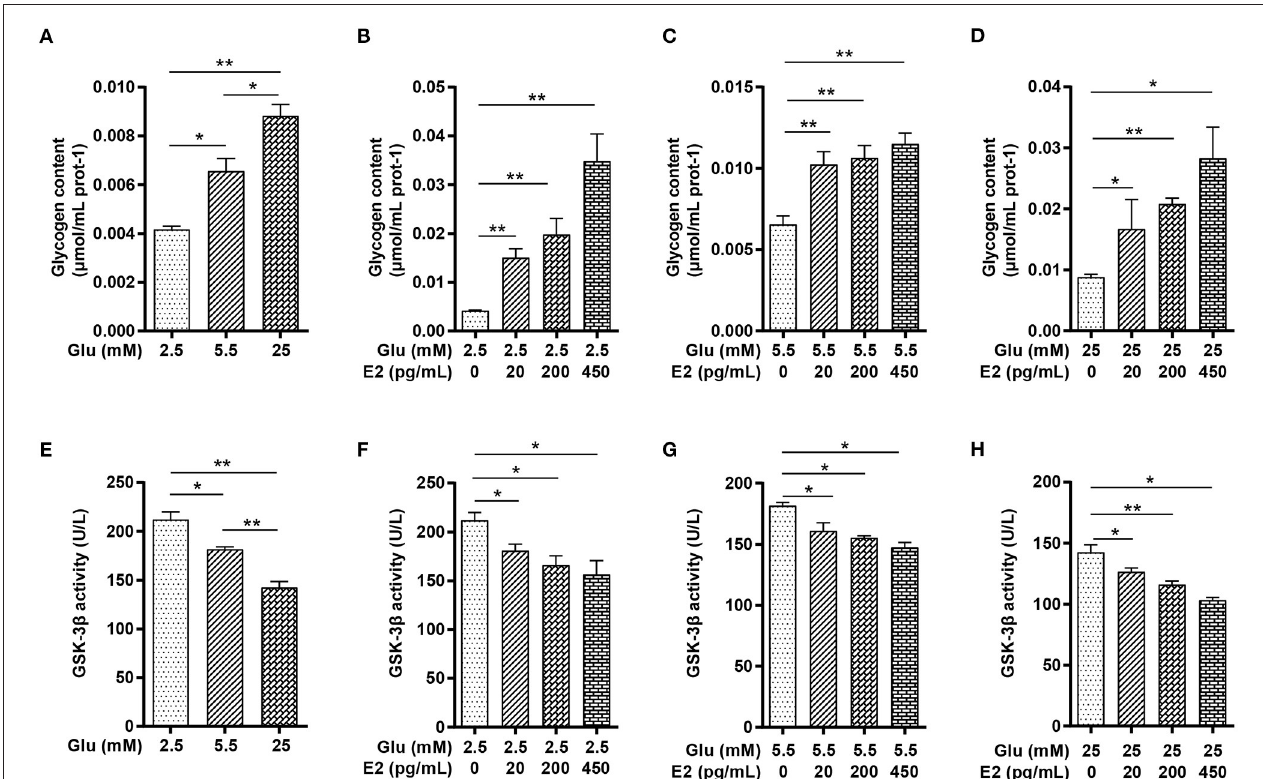
FIGURE 2 | E2 promotes PMNs glycogen synthesis by inhibiting GSK-3 β activity. PMNs was treated with LG, NG, HG, LG + EL, LG + EM, LG + EH, NG + EL, NG + EM, NG + EH, HG + EL, HG + EM and HG + EH for 6h. (A–D) Glycogen content was determined by the biochemical method. (E–H) GSK-3 β activity was determined by ELISA. The results are shown as the mean ± SD ( n = 3). Differences were analyzed using the t-test. * P < 0.05, ** P < 0.01. The significant difference between the two groups is indicated by a line and an